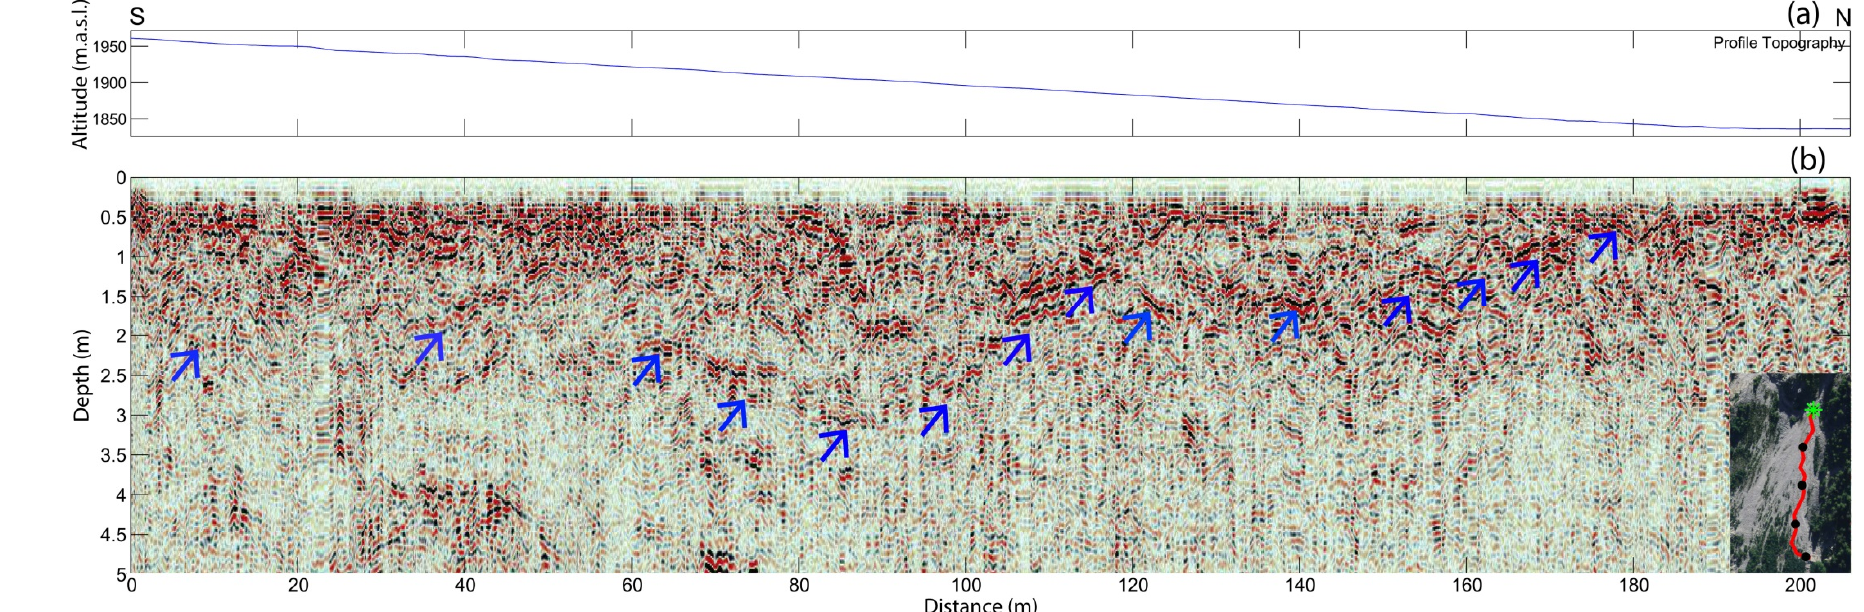
Figure 9. Resulting Ground Penetrating Radar (GPR) section from profile 8 (Figure 1b). (a) Ground elevation in longitudinal view; (b) Results after all processing steps were applied. Blue arrows indicate reflections from the bedrock interface.